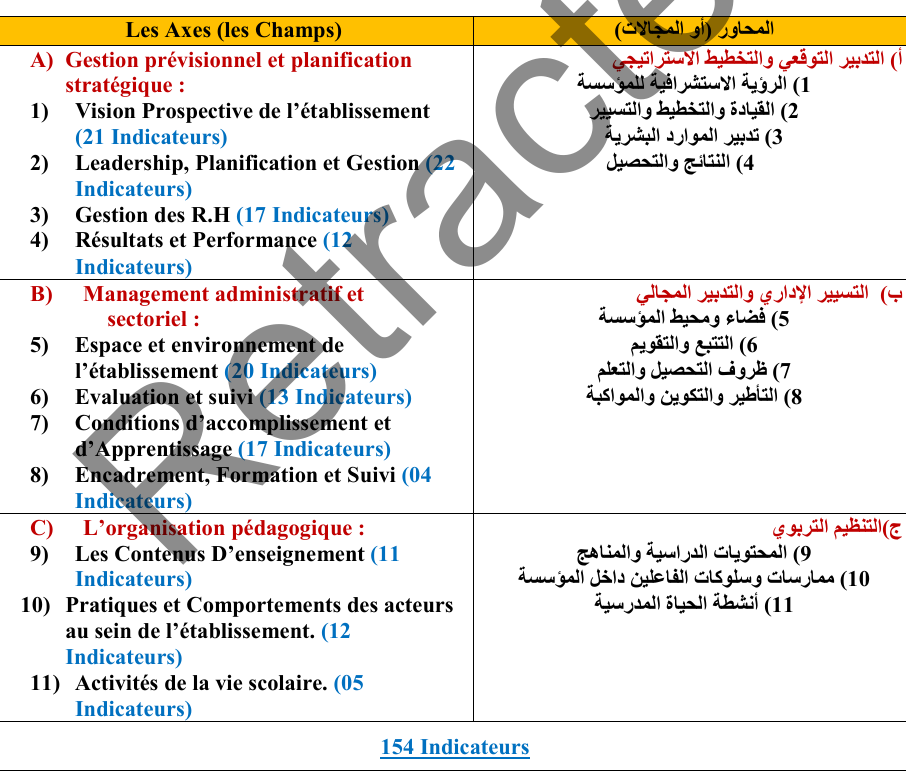
Tableau 3 : liste des indicateurs arrêtés, et leurs critères, ainsi les champs correspondants, suite au consensus de l’étape